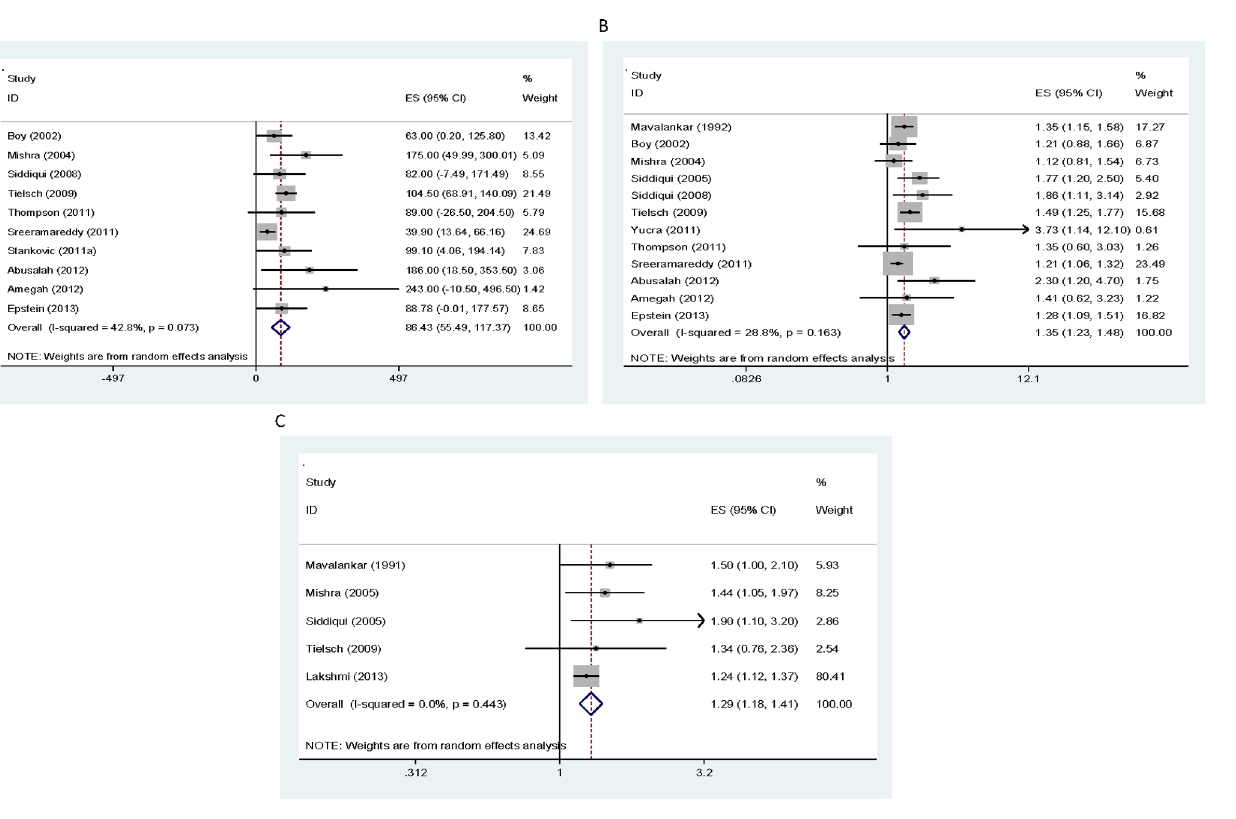
Figure 2. Forest plot showing the effect of household solid fuel use on birth weight (A), low birth weight (B) and Stillbirth (C). ES: effect size; CI: confidence